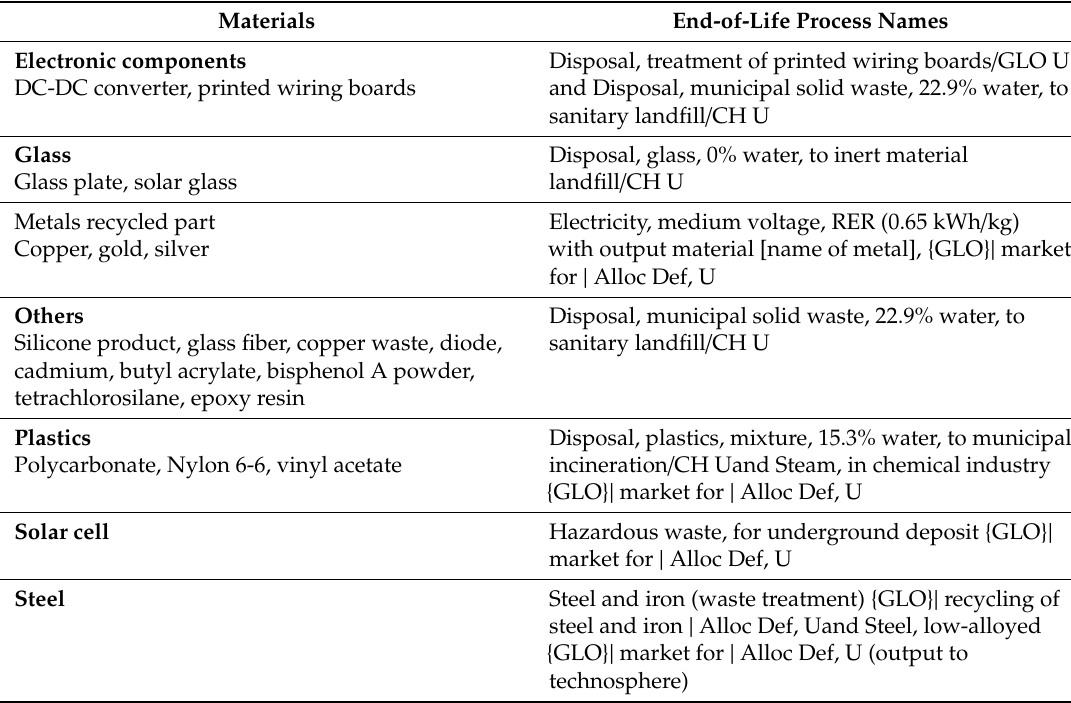
Table 2. End-of-life processes for materials and corresponding unit flows selected in